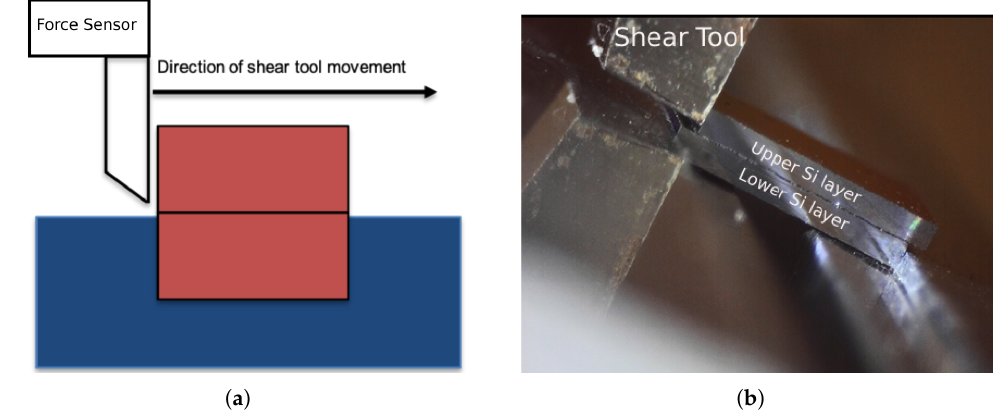
Figure 6. Die shear test setup: ( a ) die shear test working principle; ( b ) shear test inspection by usb microscope.